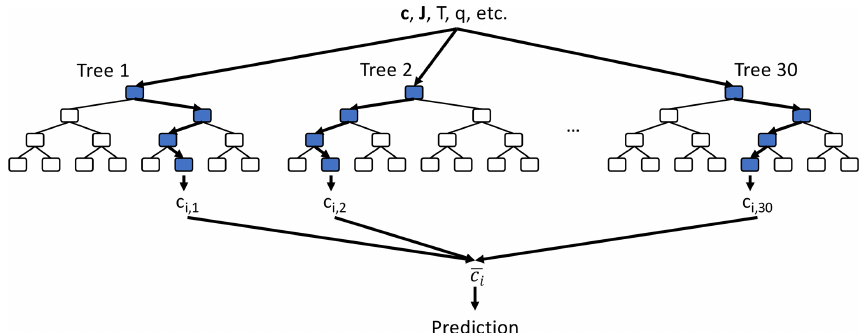
Figure 2. Schematic of random forest algorithm. For each species c i , we use a random forest consisting of 30 individual decision trees, each up to 12 layers deep (only the first four layers are shown). All decision trees take the same inputs (e.g. species concentration vector c at given location, photolysis rates J , temperature T , humidity q ) and each decision tree node uses one of the input features plus a threshold value to determine the tree path for the given set of input features. The final prediction is made by averaging the 30 individual tree predictions ( c i, 1 ,c i, 2 ,...,c i, 30